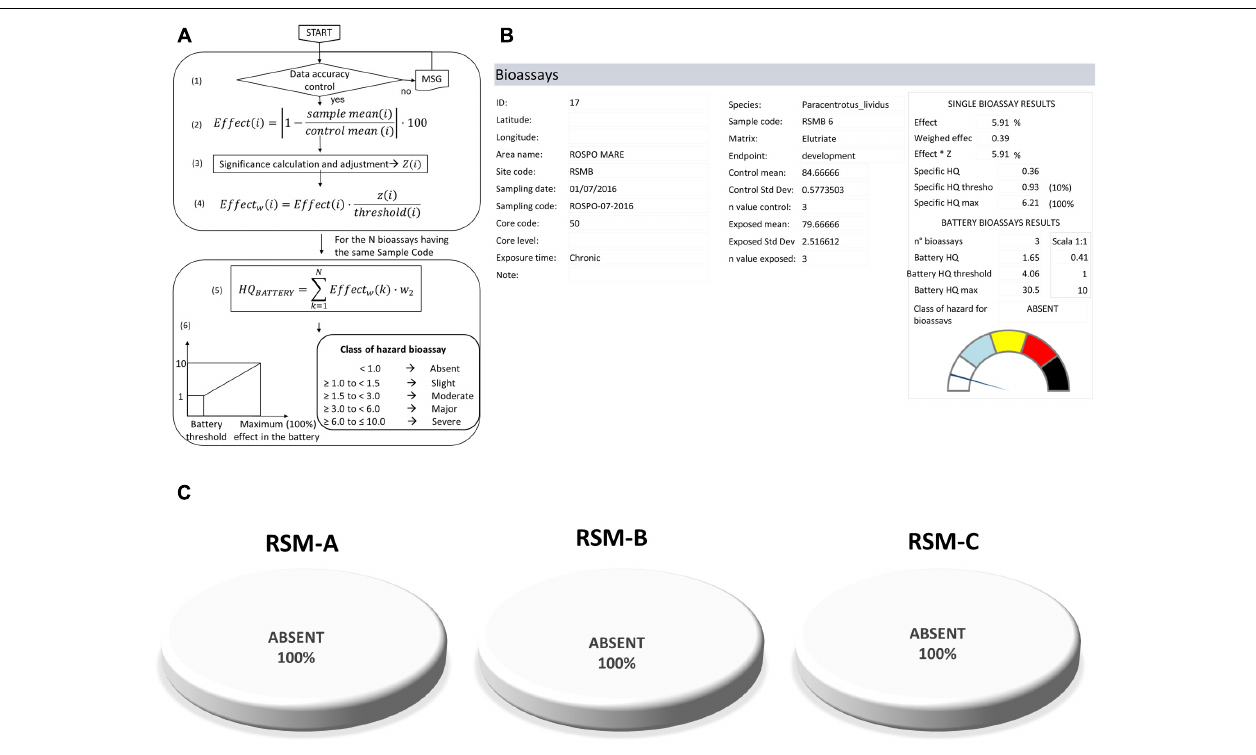
FIGURE 5 | LOE-4: elaboration of ecotoxicological bioassays. (A) Flowchart and calculations of the Battery of Bioassays Hazard Quotient (HQ BATTERY ). (B) Model output for bioassays elaborations. (C) Results obtained for the three platforms indicating a class of hazard assigned as absent in 100% of samples.